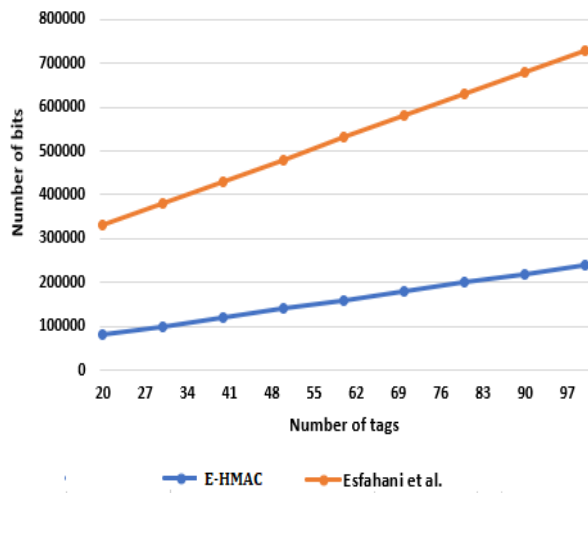
Figure 3. Total key storage size vs number of tags at the source for E-HMAC and Esfahani et